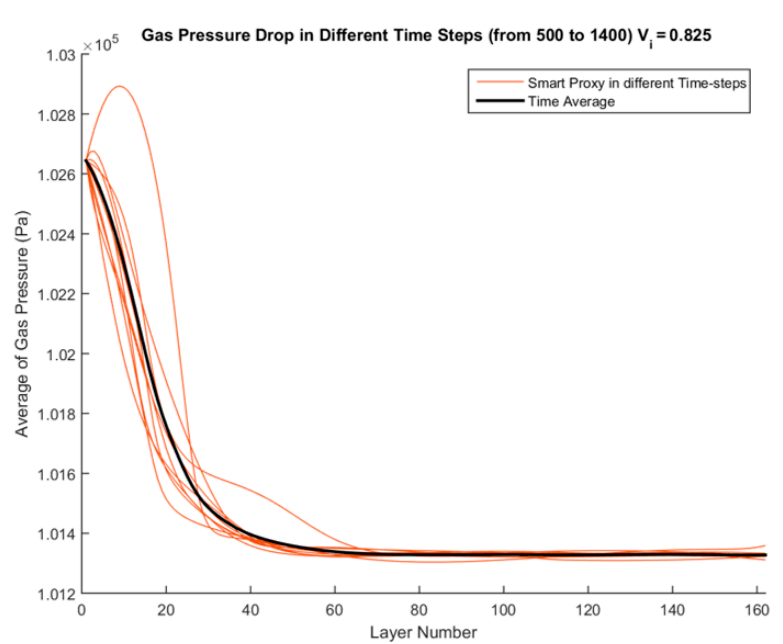
Figure 45. Spatial averaged profile of smart proxy results for gas pressure (Pa) for times 500 through = 0.825 m / s. 1400 and blind test condition of V in = 0.825 m/s. 1400 and blind test condition of V in